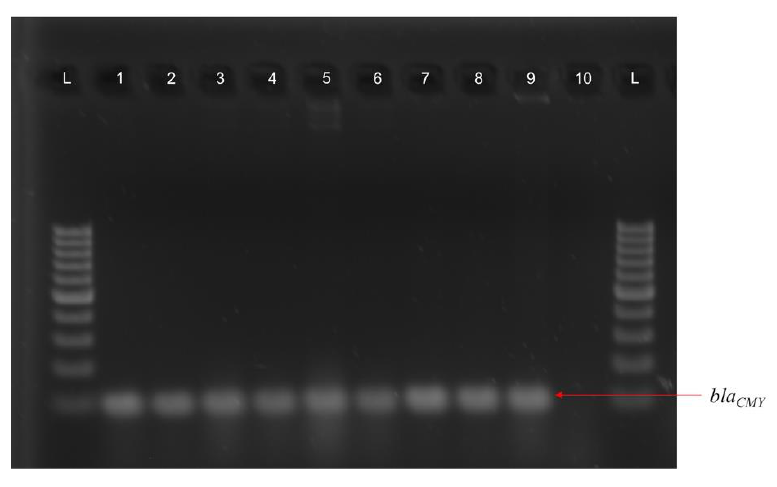
Figure 5. PCR for bla CMY in conventional cage and cage-free E. coli isolates. ( L ) 100 bp ladder, ( 1 ) IA-EC-0010; ( 2 ) IA-EC-0011; ( 3 ) IA-EC-0018; ( 4 ) IA-EC-0019; ( 5 ) IA-EC-0020; ( 6 ) IA-EC-0021; ( 7 ) IA- EC-0075; ( 8 ) IA-EC-0076; ( 9 ) χ7122 (pIA-EC-0018) transconjugant; ( 10 ) χ7122 negative control.